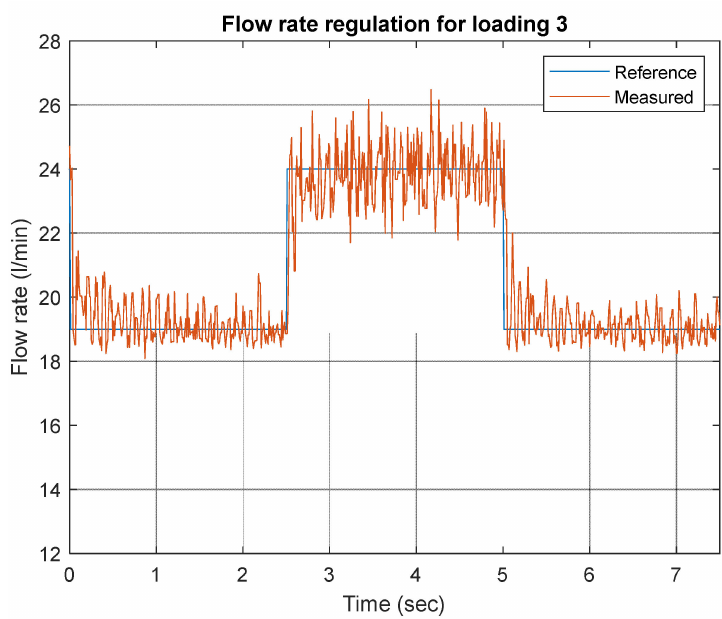
Figure 15. Experimental output flow rate data—loading